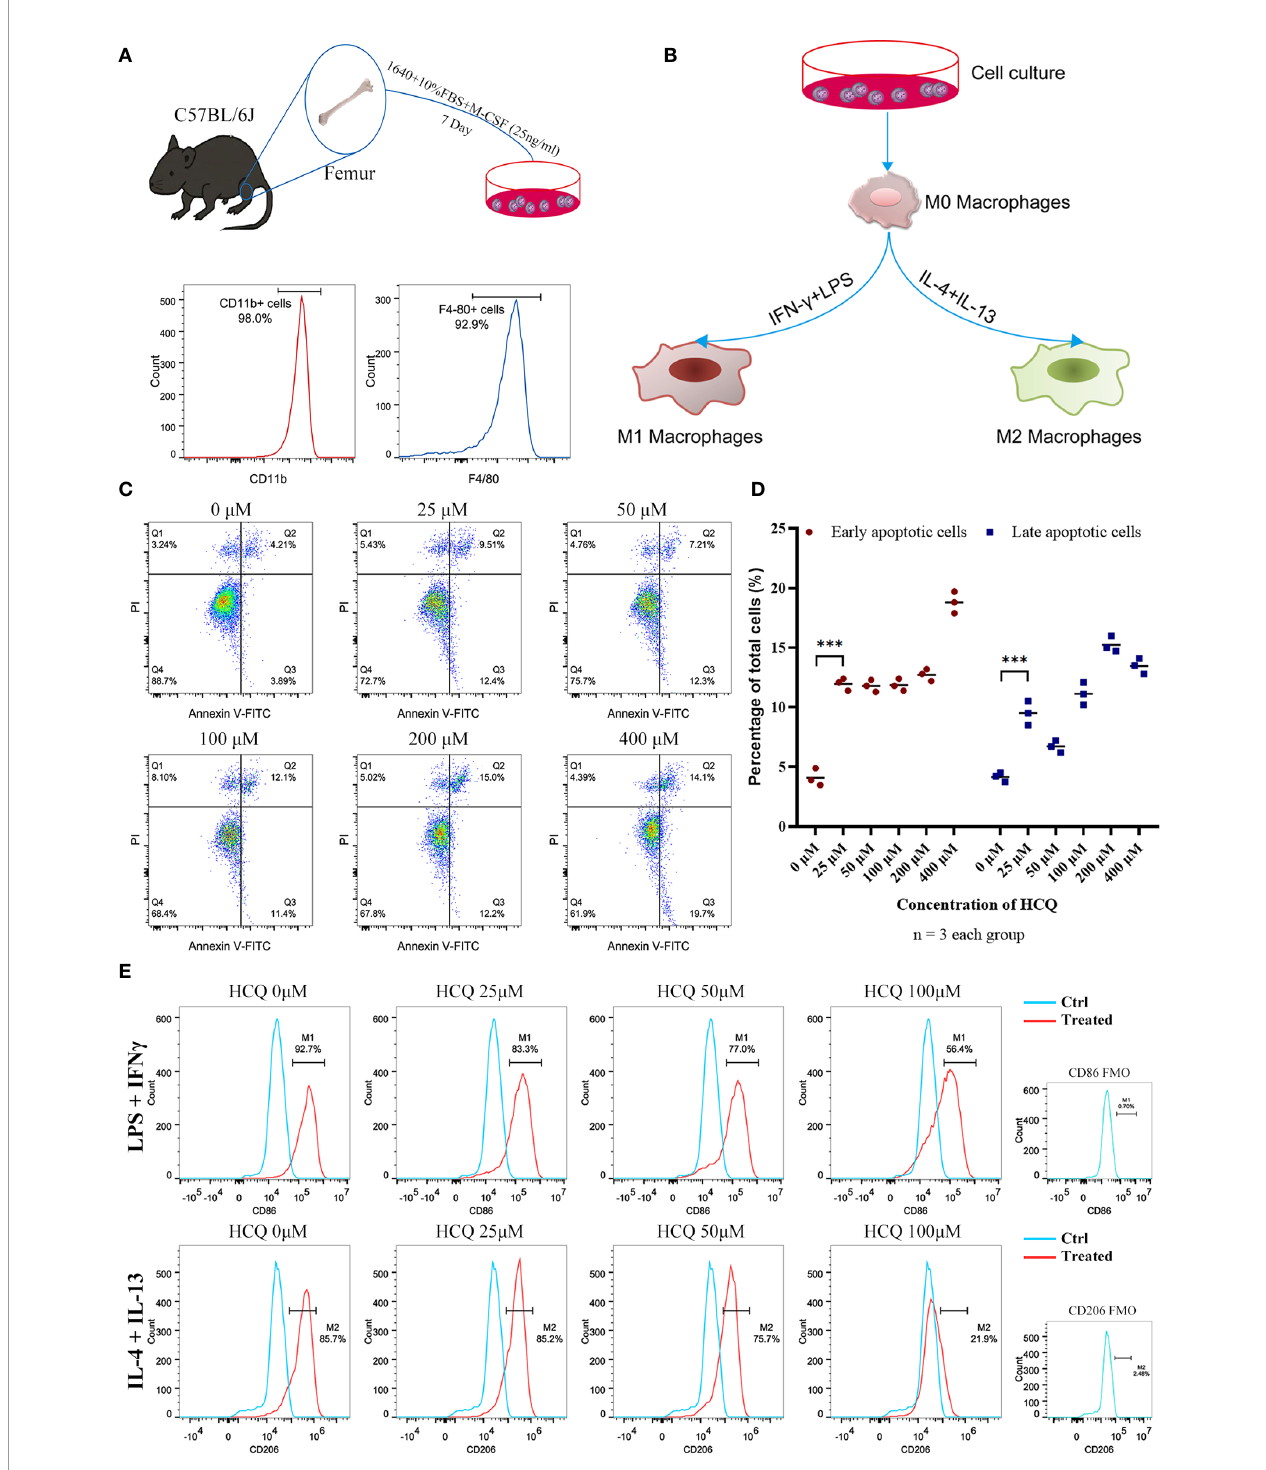
FIGURE 3 | HCQ affects differentiation of BMDMs in vitro . (A) Models of BMDM acquisition and results of purity identi fi cation. (B) Models of polarization of BMDMs. (C) Apoptosis of BMDMs was assessed using Annexin V-FITC/PI Kit. Annexin V+ PI − represents early apoptotic cells, and Annexin V+ PI+ represents late apoptotic cells. (D) Quantitative analysis of related apoptotic cells. (E) Effects of HCQ on macrophage polarization. BMDMs were polarized into M1 or M2 subsets, and various concentrations of HCQ were added for 24 h to assess the effects of HCQ on the differentiation of macrophages. Data are represented as means and analyzed using the Student ’ s t test. ***P <